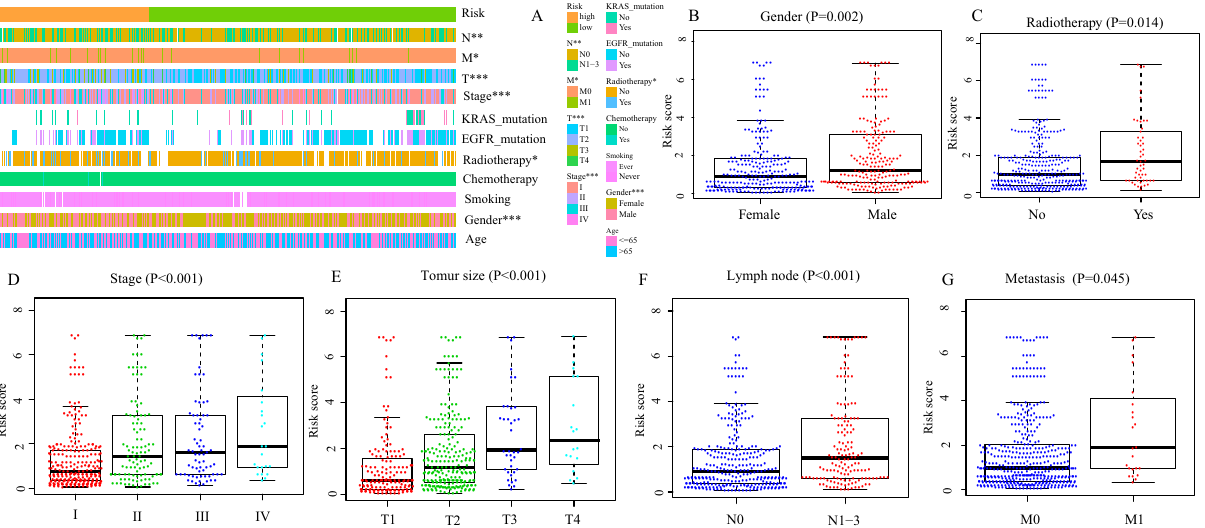
Figure 6. Correlation between the IRGPs signature and clinical characteristics. ( A ) Heat map for the distribution of clinicopathological features between high- and low- risk group. ( B ) The difference of risk score between different gender, ( C ) between patients with and without radiotherapy, ( D ) among different TNM grades, ( E ) among different tumor size, ( F ) between with and without lymph node metastasis, ( G ) between with and without distance metastasis. * P < 0.05, ** P < 0.01, *** P < 0.001.